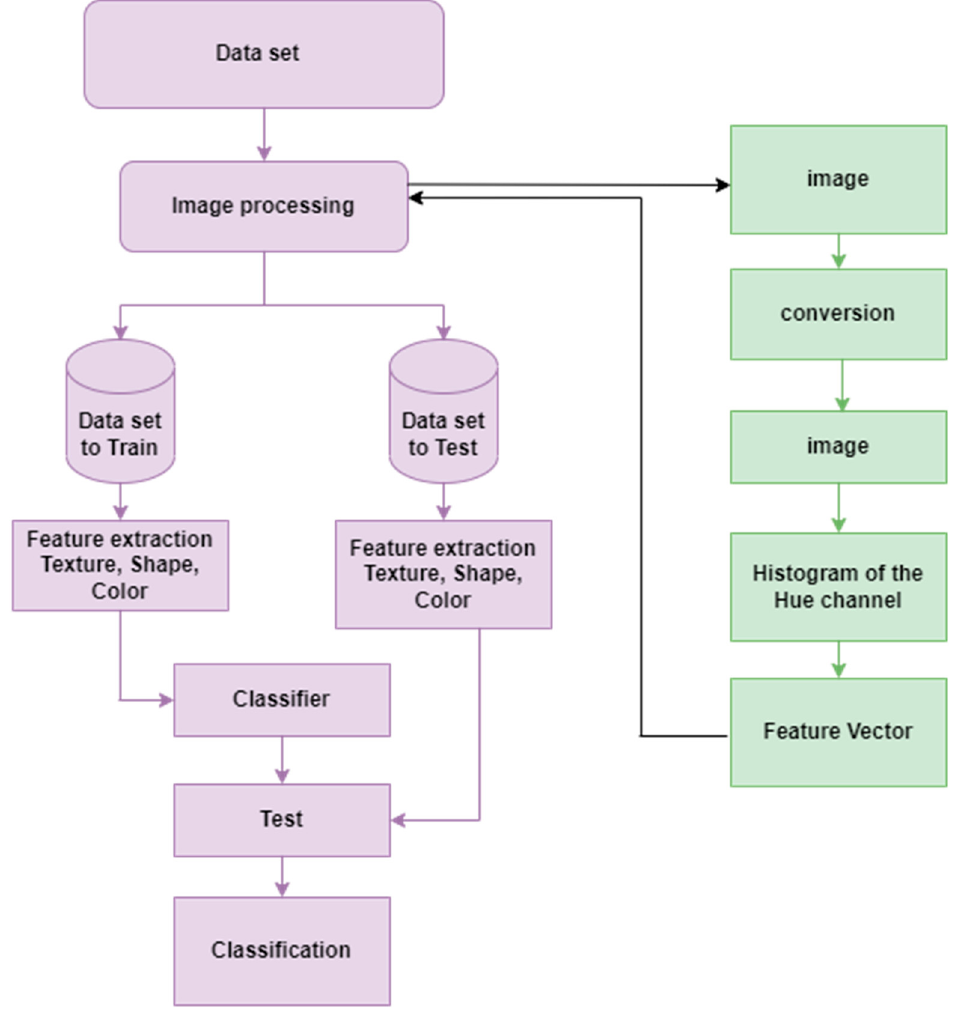
Figure 4. The scheme of operation of the recognition module.